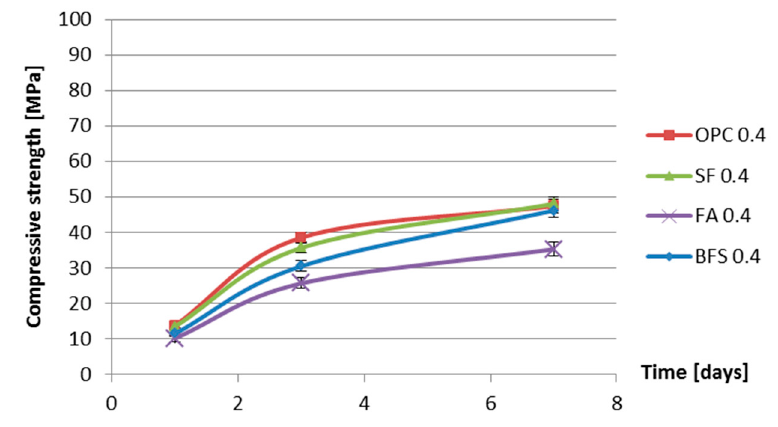
Figure 10. Compressive strength vs. age for different cement pastes with water–binder ratio of 0.3.